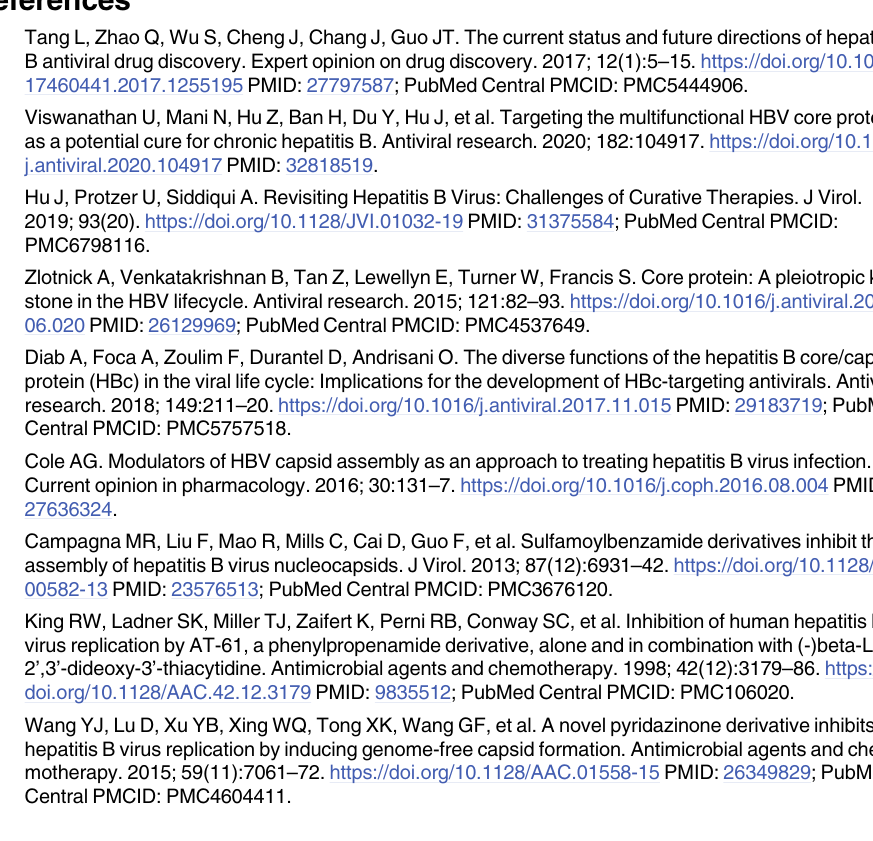
S13 Fig. STUB1 has no significant effect on HBsAg in HBV transgenic mice. HBV trans- genic mice were treated as described in Fig 8. The level of HBsAg in serum was quantified every 6 d.